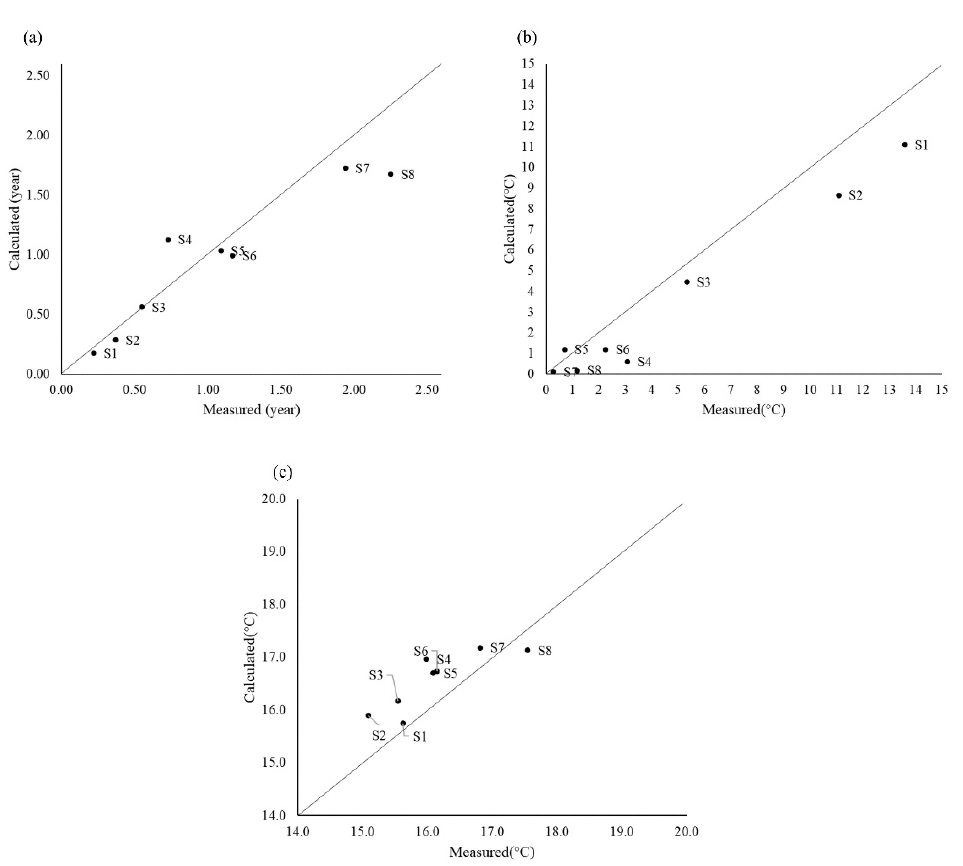
Figure 11. Phase difference ( a ), maximum-minimum ( b ), and average groundwater temperature ( c ) between measured and calculated.